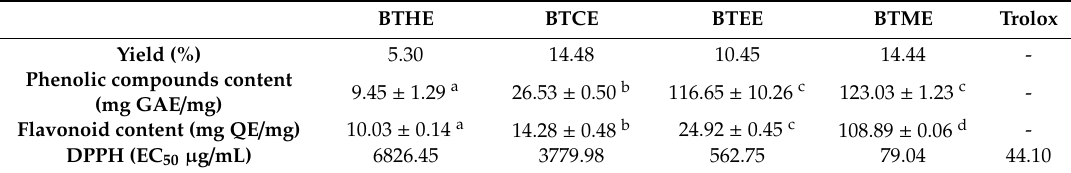
Table 1. Comparative analysis of total phenolic compounds, flavonoid content, and DPPH radical scavenging of the crude extracts from the leaves of Buchenavia tetraphylla . BTHE BTCE BTEE BTME Trolox Yield (%) 5.30 14.48 10.45 14.44 - Phenolic compounds content 9.45 ± 1.29 a 26.53 ± 0.50 b 116.65 ± 10.26 c (mg GAE / mg) Flavonoid content (mg QE / mg) 10.03 ± 0.14